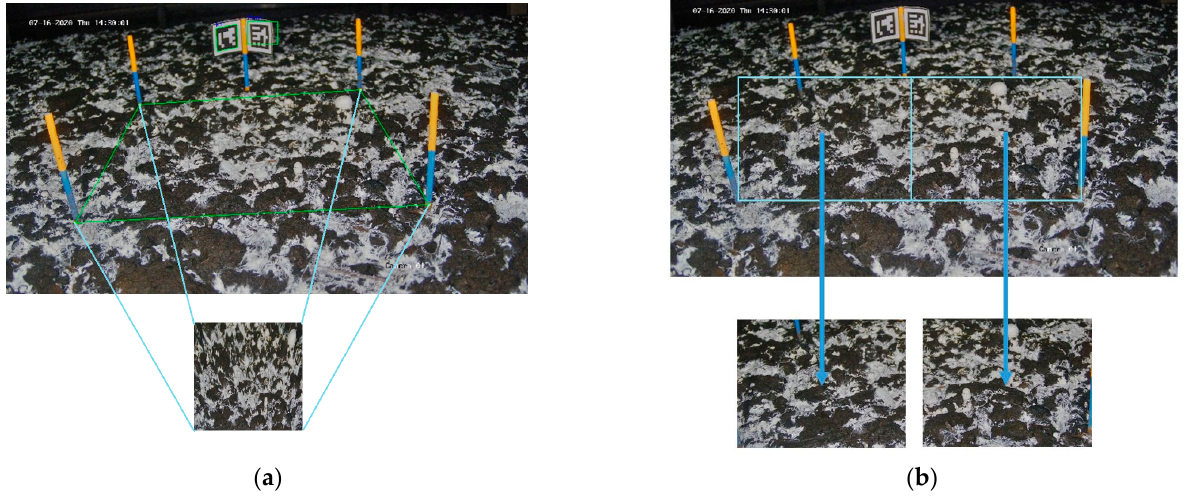
Figure 5. Image preprocessing scheme for Fourier and morphological analysis ( a ) and for the object detection model ( b ).